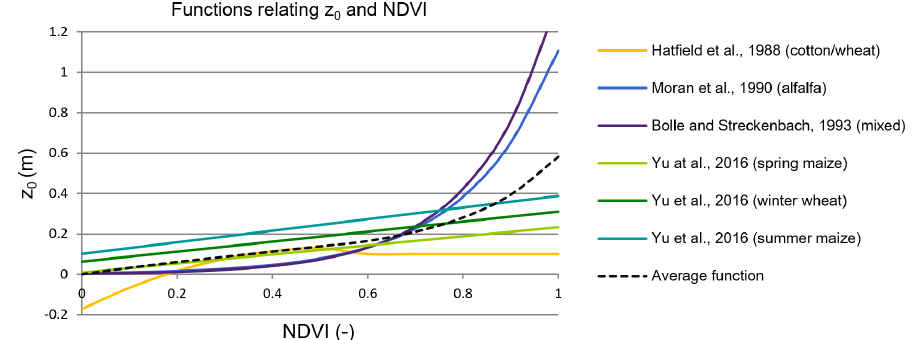
Figure 1. Several functions that relate the roughness length z 0 (m) to the normalized difference vegetation index (NDVI). The dotted line shows the average of all the functions. This function is used to compute NDVI-dependent z 0 values for the subcategories within DEPAC classes “arable”, “other” and “permanent crops”.